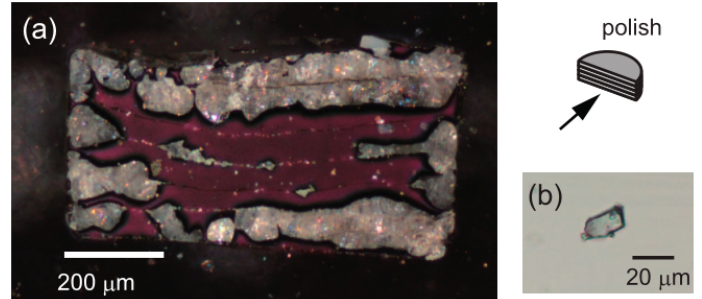
Figure 4. ( a ) Polarized micrograph of a longitudinal section of a recovered disk sample hydrogenated at 650 °C and 10.0 GPa for 24 h. ( b ) Transmitted light micrograph of the obtained AlH3 single crystal. Reprinted with permission from ref. [43]. Copyright 2008 AIP Publishing.